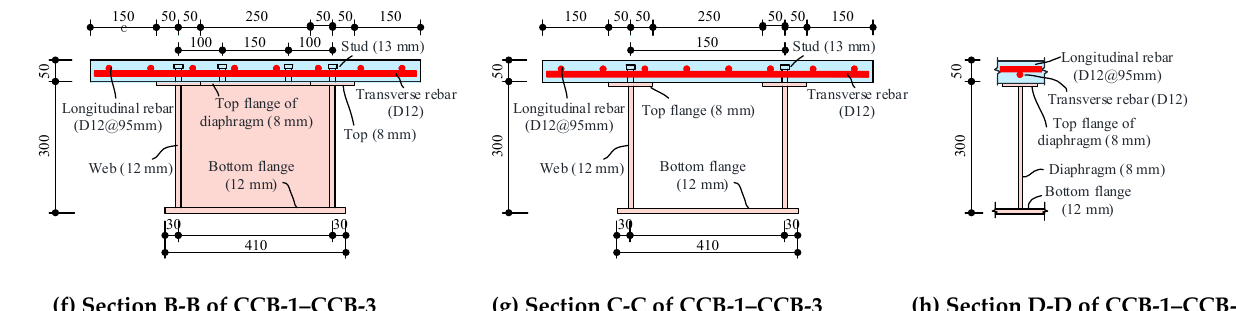
Figure 2. Details of the test specimens (in units of mm).